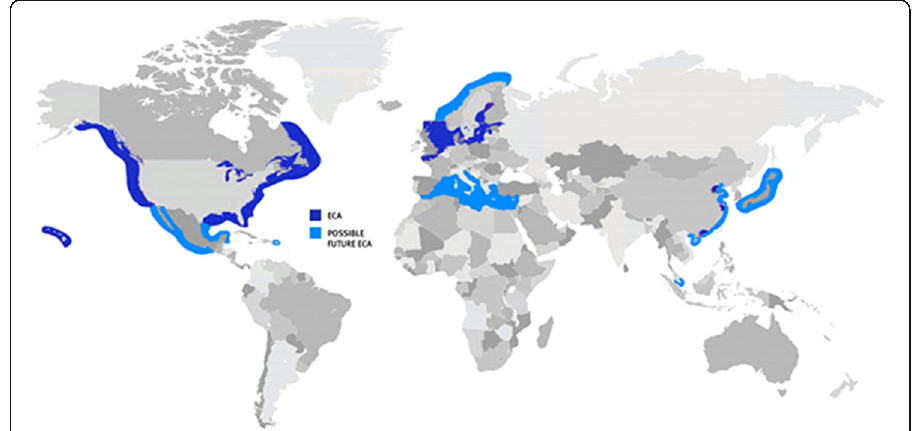
Fig. 1 Current and possible future ECA ’ s. Source: http://www.kolbia.org (Kolbia